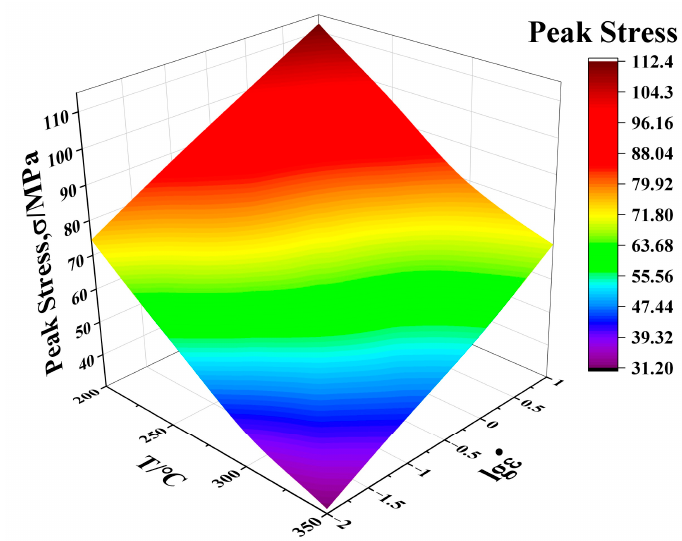
Figure 4. Peak stress of Mg-3Bi alloy under different deformation conditions.